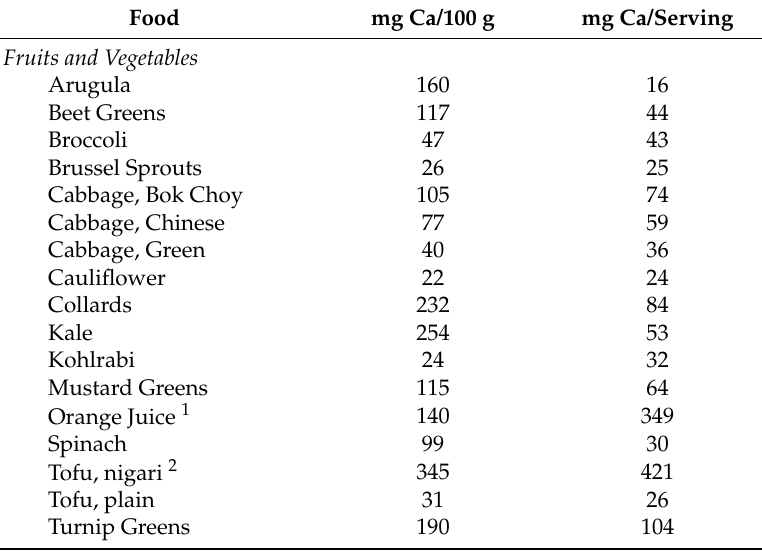
Table 3. Non-dairy sources of calcium in the diet